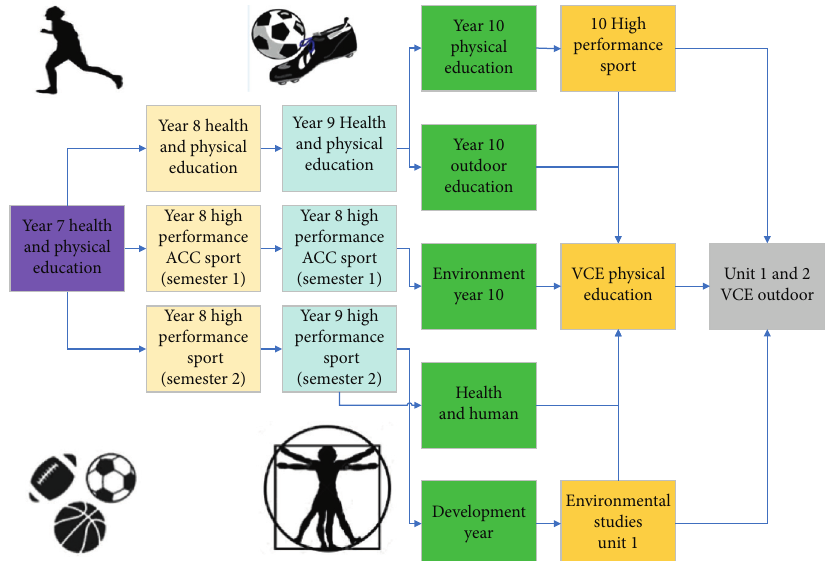
Figure 2: The design of physical education effectiveness